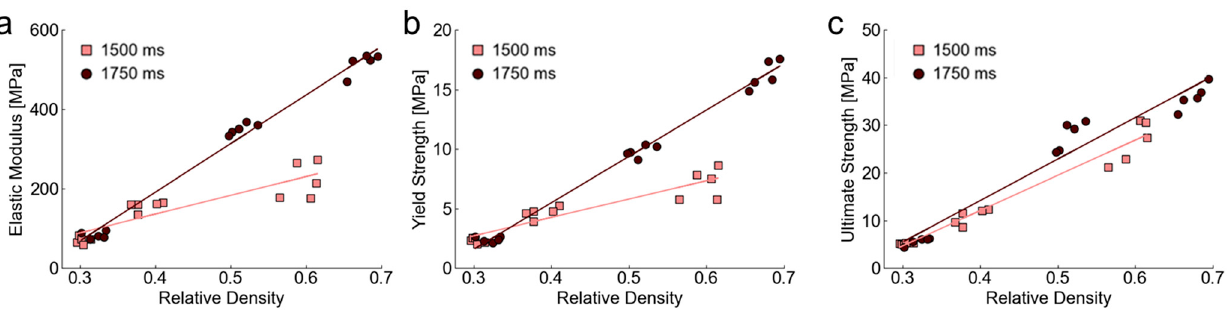
Figure 16. Mechanical property measurements for each tested sample of differing exposure times according to relative density for ( a ) elastic modulus E m , ( b ) yield strength Y s , and ( c ) ultimate strength U s .